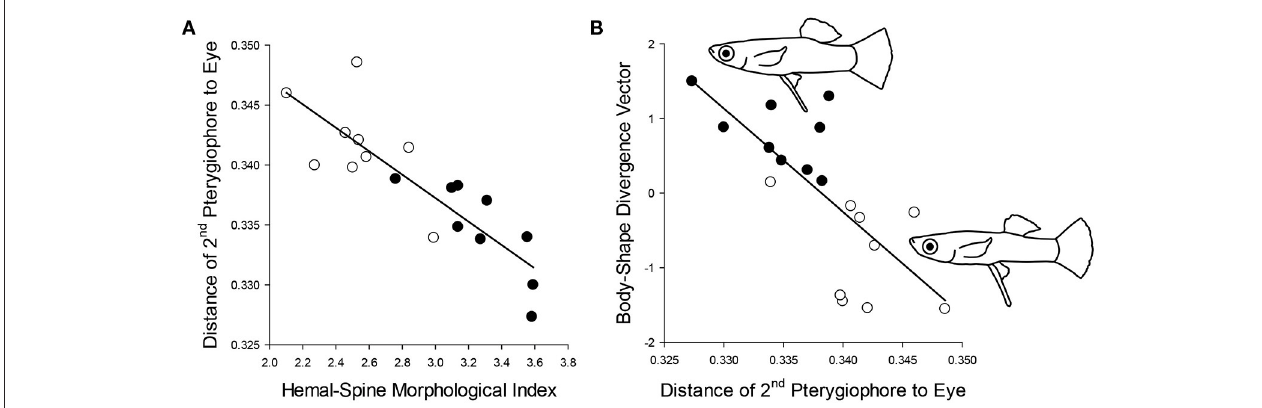
FIGURE 5 | Bahamas mosquitofish populations with (A) more numerous, larger, and more curved modified hemal spines (positive scores on hemal-spine morphological index) exhibit greater gonopodial anterior transposition (shorter distance between the second pterygiophore and the eye), and consequently (B) these populations also exhibit bodies with larger caudal regions (relatively larger trunk/caudal region and smaller head, positive scores on body shape divergence vector; see Supplementary material for details). Population means depicted; open symbols: blue holes without predatory fish; filled symbols: blue holes with predatory fish; line drawings illustrate representative body shapes of fish from blue holes with and without predatory fish (dotted line depicts outline of anal-fin ray 5, distinguishing the gonopodium from the rest of the anal